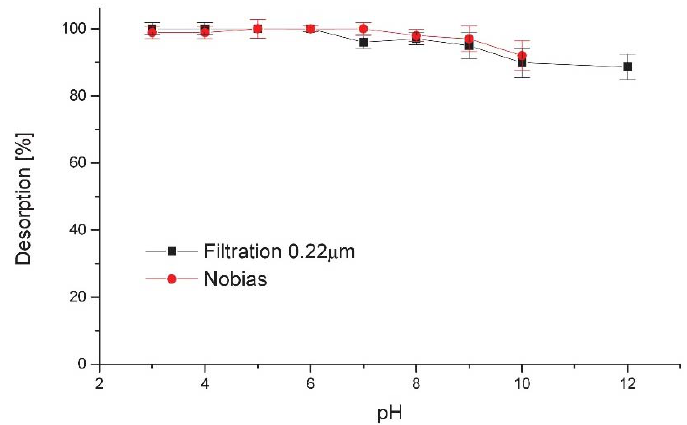
Figure 2. The effect of pH on the desorption of 44 Sc(III) ions with 2 mol L − 1 HCl on 10 mg Nobias resin and precipitation on a 0.22 μ m filter.